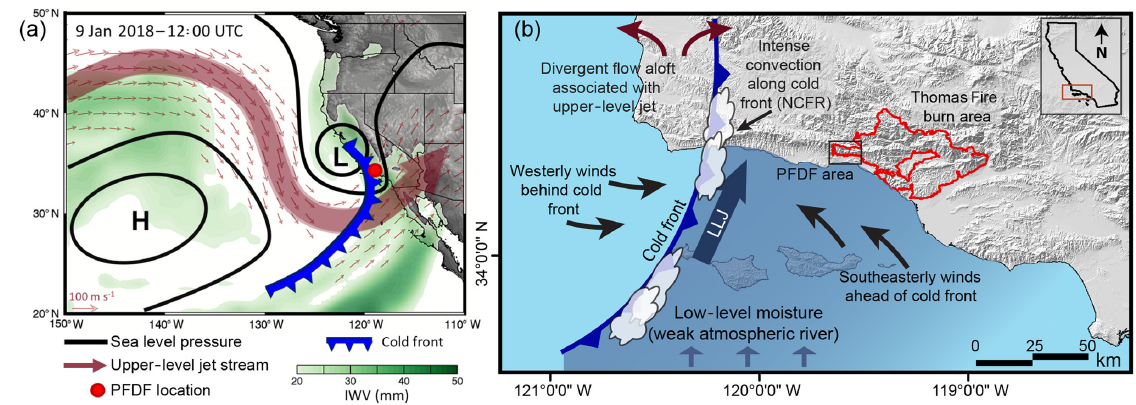
Figure 3. (a) A conceptual synoptic view of conditions at 12:00UTC 9 January 2018 based on information from the Climate Forecast System version 2 operational analysis (https://www.ncdc.noaa.gov/data-access/model-data/model-datasets/climate-forecast-system-version2-cfsv2, last access: 5 November 2018). (b) A conceptual mesoscale view of conditions preceding the event as the cold front approaches the Thomas Fire burn area.